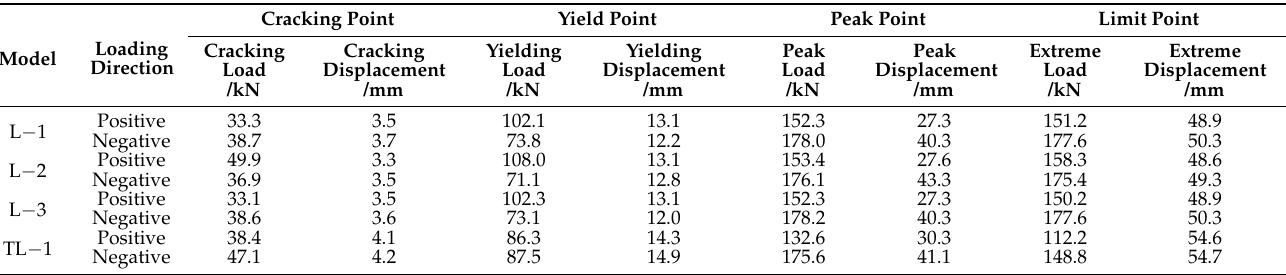
Table 6. Feature point